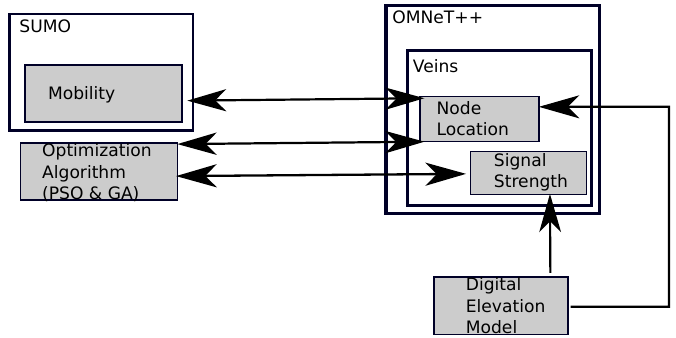
Figure 3. Testing Framework